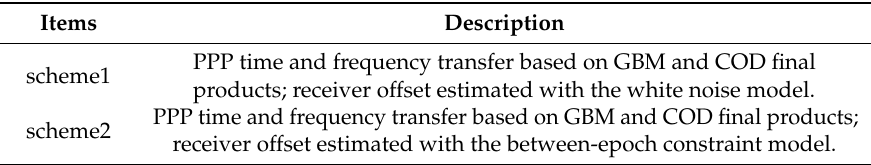
Table 5. Summary of the multi-GNSS PPP time transfer schemes.